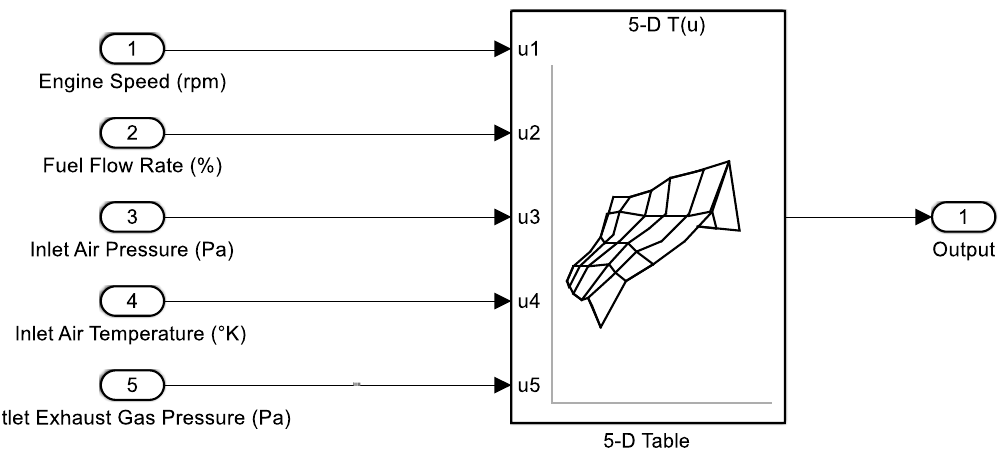
Figure 2. Example of in-cylinder phenomena modelling by a five-dimensional (5-D) matrix (Simulink environment).